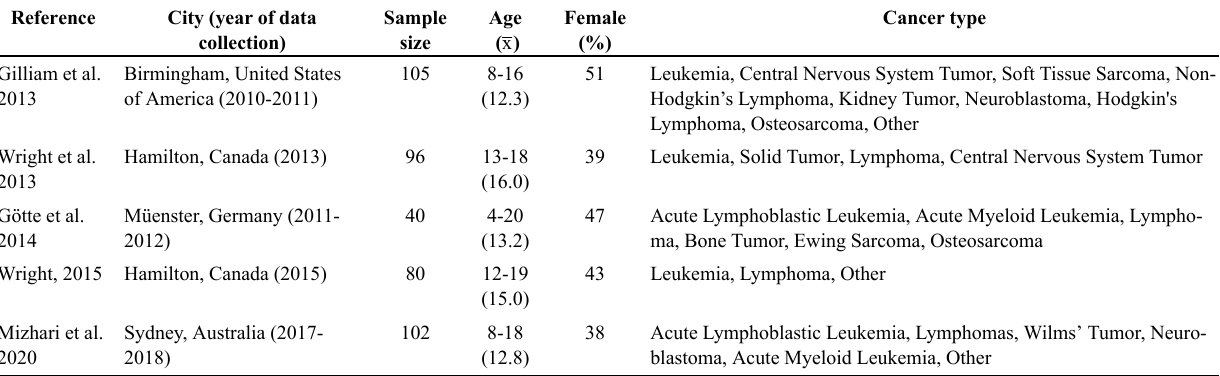
Table 1 - Location identification and characteristics of the study